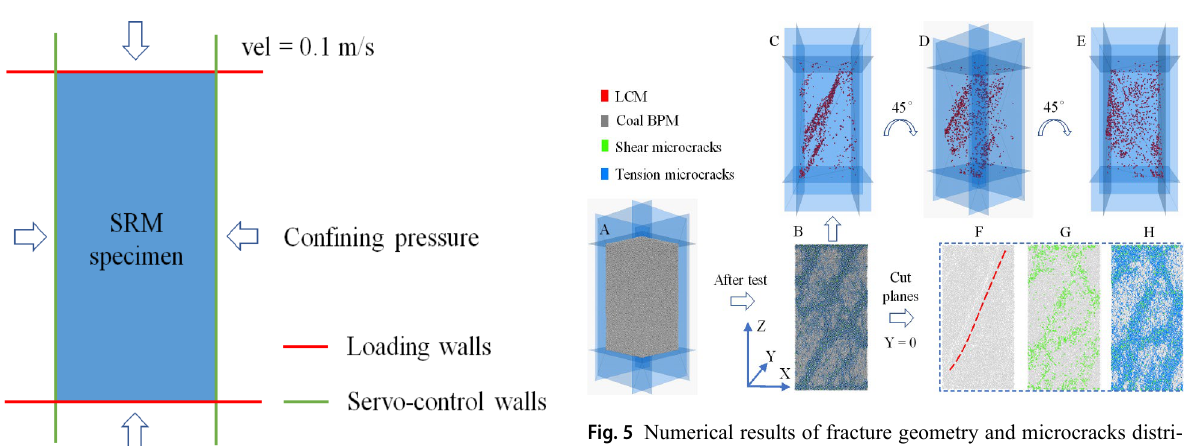
Fig. 5 Numerical results of fracture geometry and microcracks distri - bution for intact coal with REV size after triaxial compression test